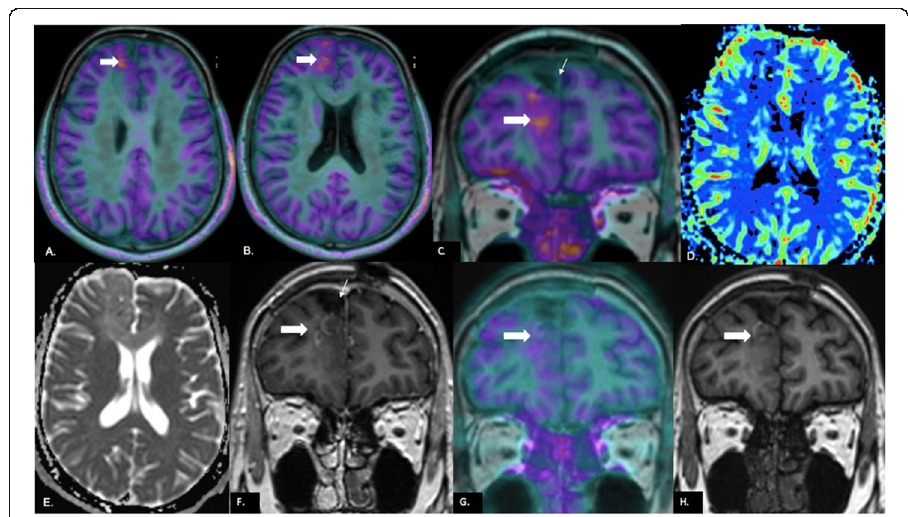
Fig. 6 Discordance between PET, perfusion and diffusion in a case of recurrence: 31-year-old male operated for right frontal ODG 14 months back; last radiation dose 10 months ago. PET images fused with axial T1 MPRAGE ( A , B ) show an area of uptake in the right superior frontal gyrus (white arrow in A , B ). The uptake (block white arrow) is seen along the margins of the resection cavity (small white arrow) on the coronal fused PET-MR image ( C ). rCBV map ( D ) generated using the leakage correction algorithm shows no unequivocal elevation of perfusion in the area. There is no diffusion restriction on the ADC map ( E ). Few foci of enhancement (block white arrow) are seen along the margins of the resection cavity (small white arrow) on post-contrast coronal T1 MPRAGE ( F ). In view of PET uptake, recurrence was suspected and chemotherapy administered. Follow-up PET image after chemotherapy fused with coronal T1 MPRAGE ( G ) shows reduction in the degree of uptake (block white arrow) along the resection cavity margin when compared with prechemo coronal PET image in C . Reduction in the degree of enhancement is also seen on the follow-up post-contrast coronal T1 MPRAGE (white arrow in H ) compared to that in